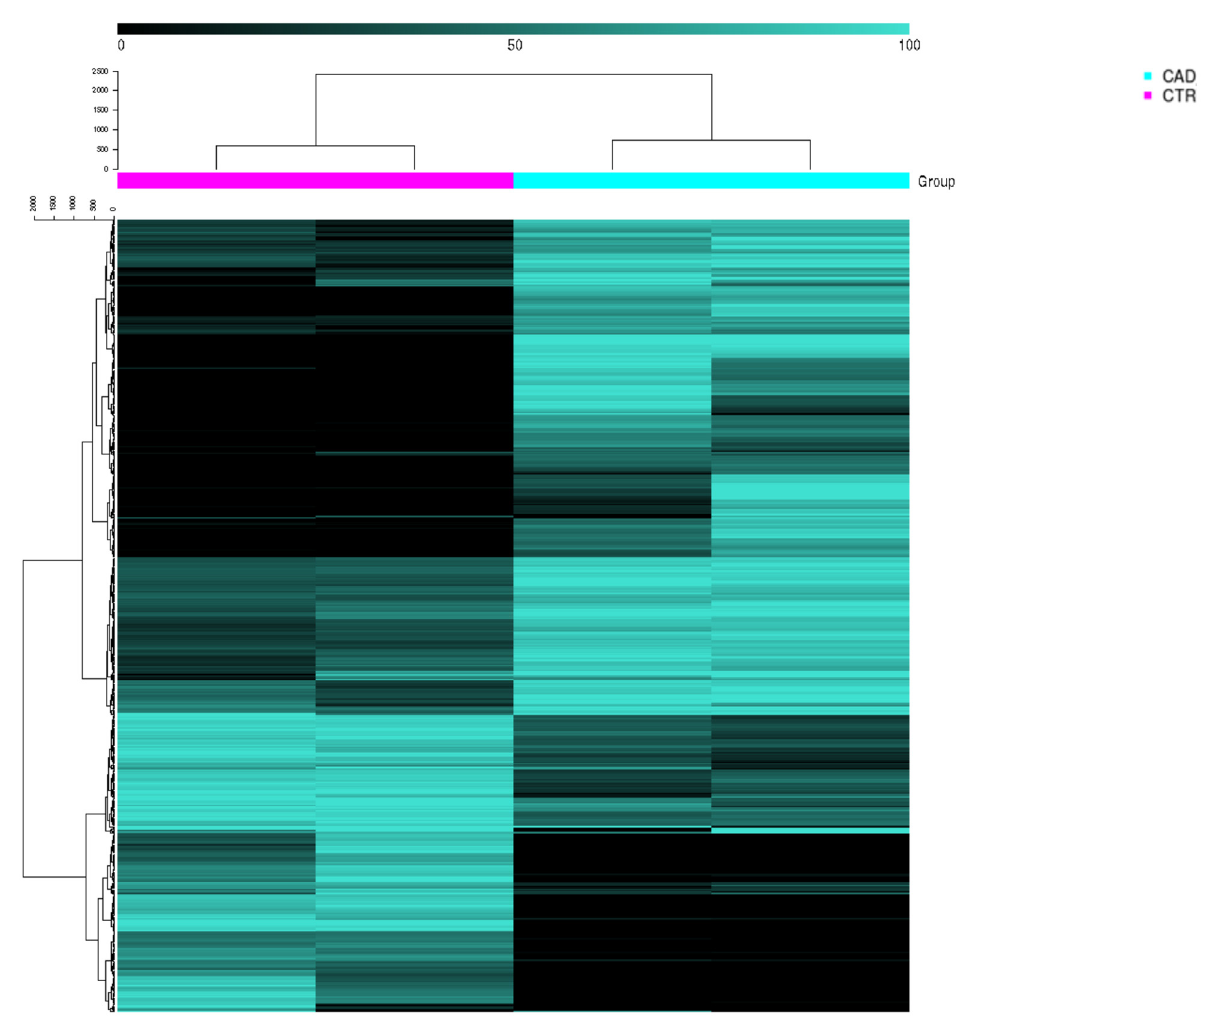
Figure 1. HCA analysis and heat maps of genome-wide methylation study. Graphical representation of the single sites differentially methylated (DMCs). Black represents hypomethylated genomic regions (0% of methylation), while light green—the hypermethylated ones (100% of methylation). Only the DMCs with Δ Meth > 50% have been depicted.